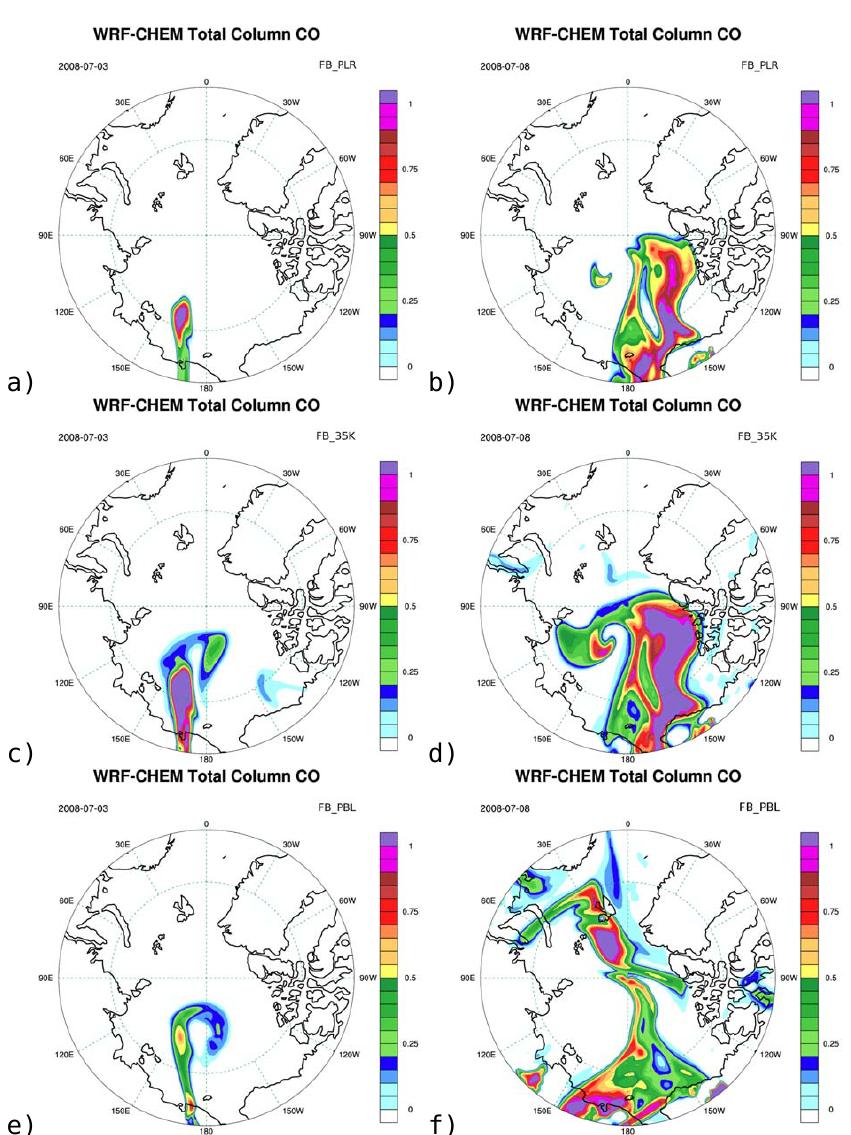
Fig. 12. Normalized WRF-Chem Total Column CO for two northern branches of the Russian plume over the Arctic Ocean for a, b) FB_PLR, c, d) FB_35K, and e, f) FB_PBL on a, c, d) 4 July and b, d, e) 8 July 2008.